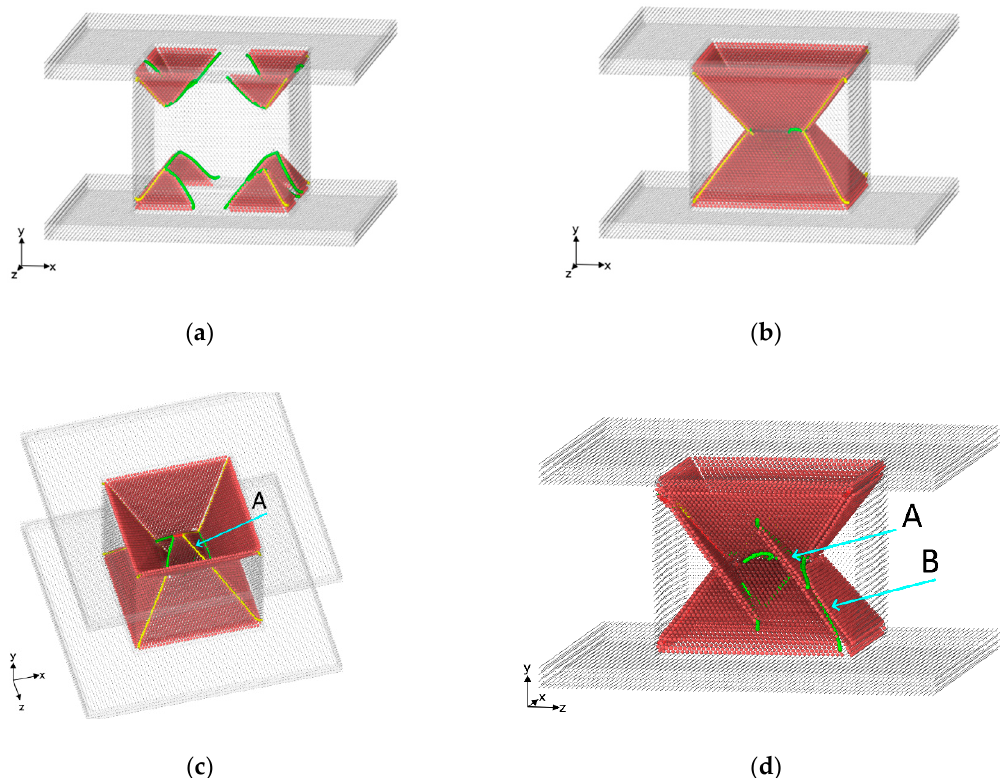
Figure 5. Deformation patterns in a < 001 > single crystal with h / d = 1 and {110} lateral faces at a sequentially increasing strain of ( a ) 7.0%; ( b , c ) 7.1%; ( d ) 8.7%.